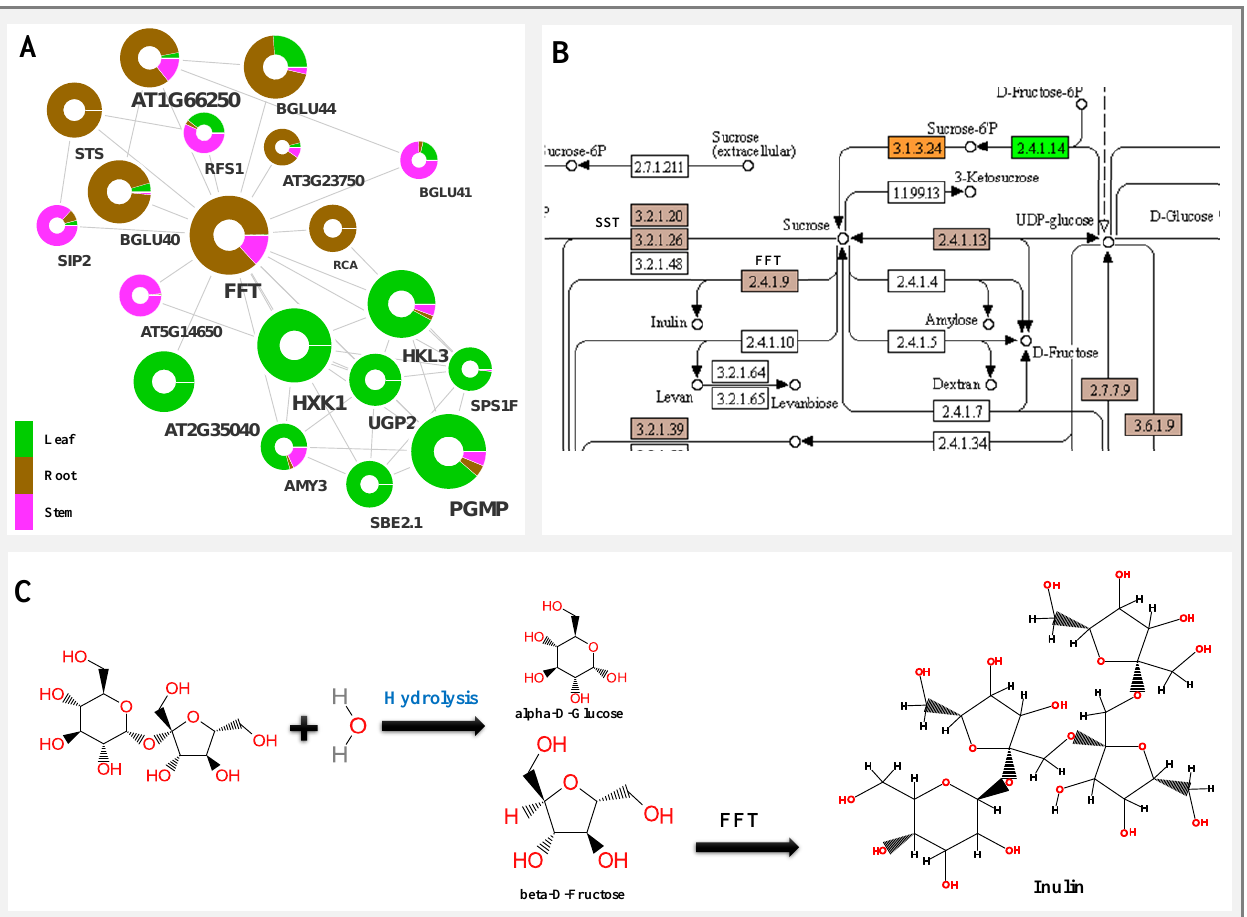
Figure 7. ( A ) Predicted network representing enriched unigenes corresponding to starch and su- crose metabolic biosynthesis complementing the ( B ) enriched KEGG pathway; ( C ) inulin synthesis involving hydrolysis of sucrose followed by conversion of beta-D fructose to inulin via FFT